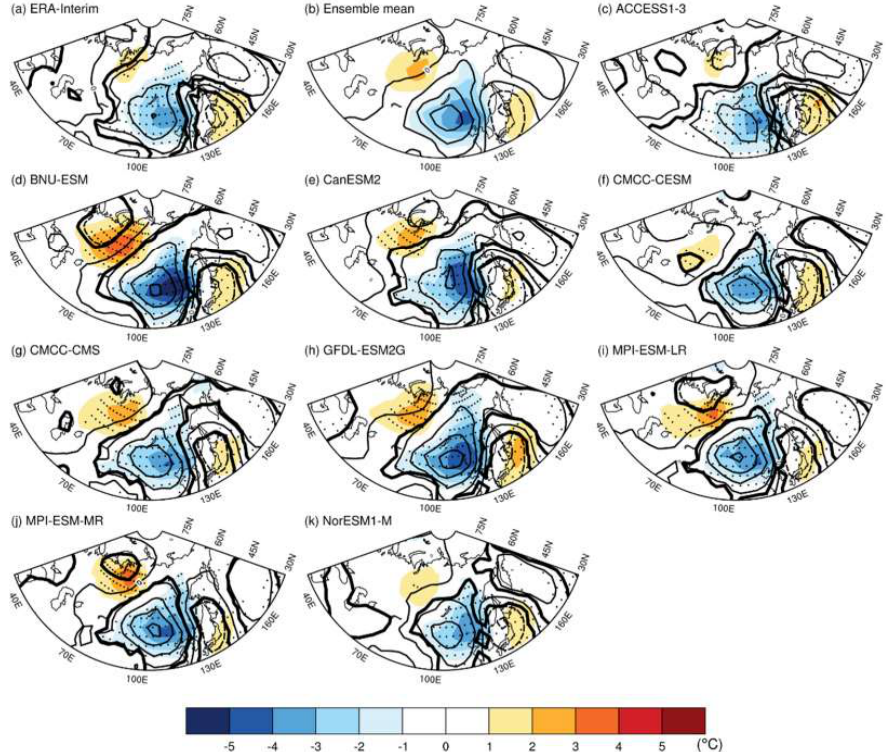
Figure 3. Composite of SLP anomalies (contour interval of 2 hPa; values significant at the 99% confidence level are represented by thick lines) and SAT anomalies (shading; values significant at the 99% confidence level are represented by black dots) for cold surge occurrence dates identified in the ERA-Interim data, the output of the nine CGCMs for the historical run, and the ensemble mean of the CGCMs for the historical run.